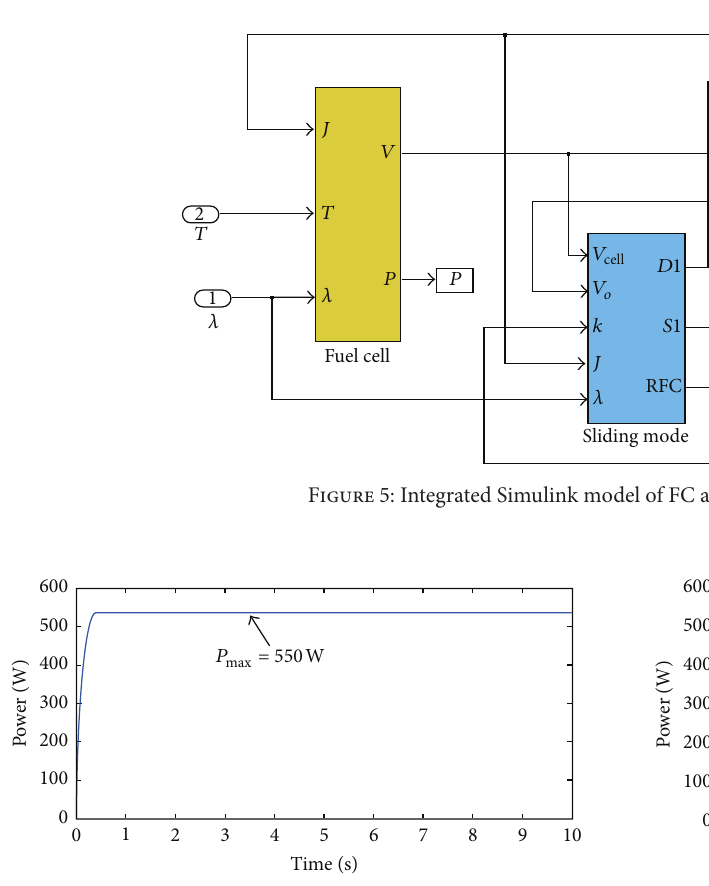
Figure 6: Evolution of FC output power under normal operating conditions.